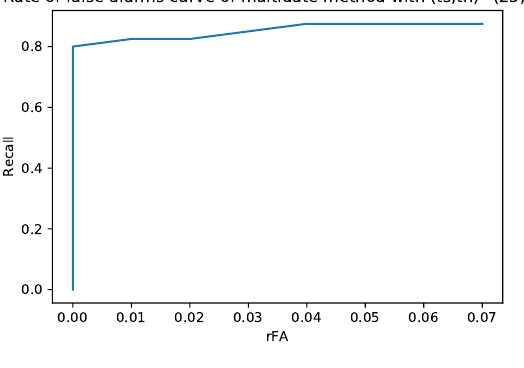
Figure 6. rFA of the multidate method.